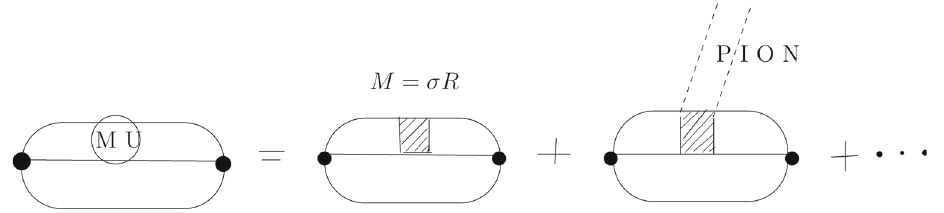
Fig. 1 The effective chiral confining kernel M s ˆ U comprising confinement in M s and chiral mesons in ˆ U ˆ ∂ ˆ U part of Lagrangian As a result the quadratic in